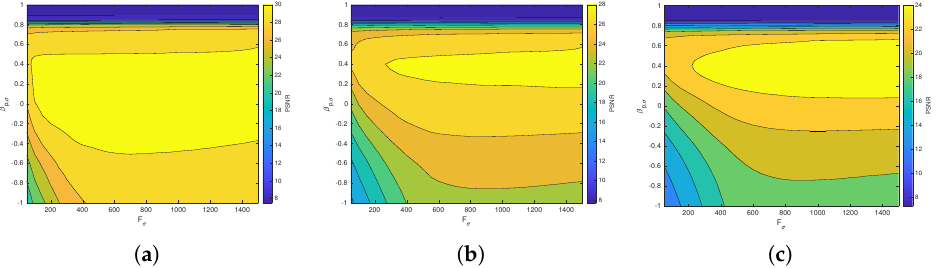
Figure 7. Surface plots for the dependence of the PSNR metric on the values F σ and β p , σ . Axial view corrupted with Gaussian σ and impulsive noise p . ( a ) σ = 10, p = 0.1. ( b ) σ = 20, p = 0.2. ( c ) σ = 30, p = 0.3.